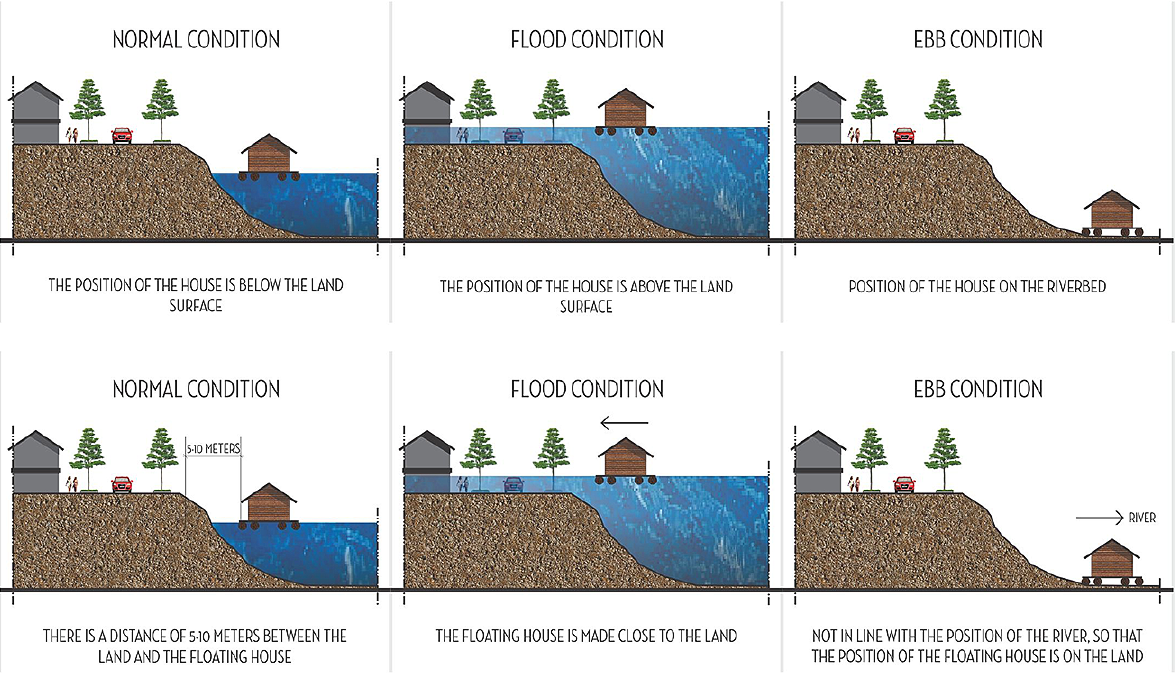
Figure 17. Position modification in floating house